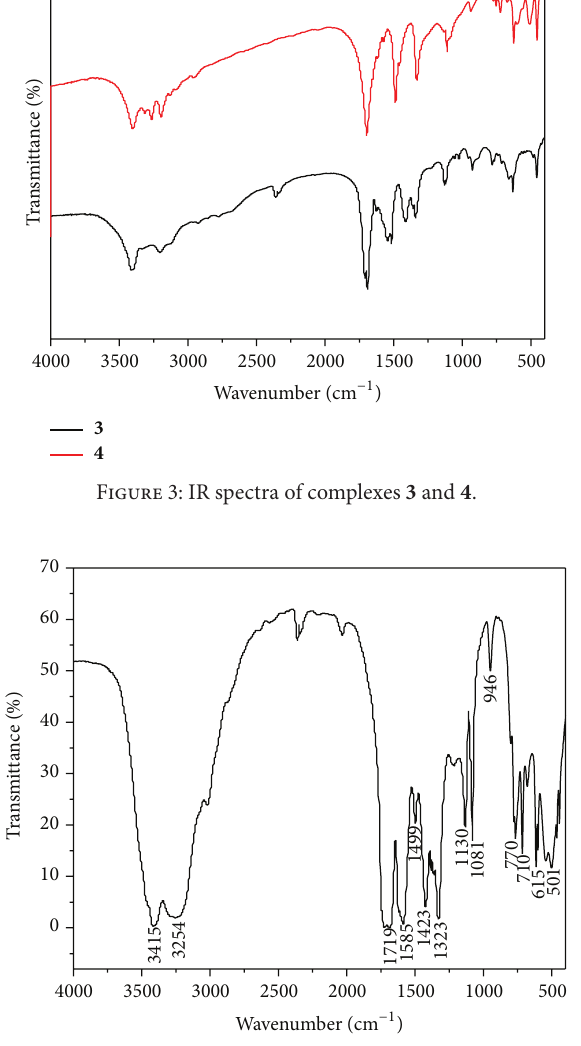
Figure 4: IR spectrum of biuret.